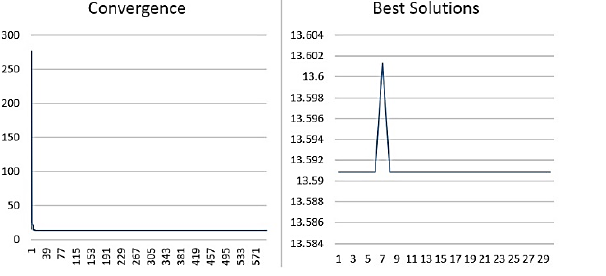
Figure 6. Convergence curve and 30 best solutions for constraint problem 3 Table 6. Reported result for constrained problem 4 from DGE+